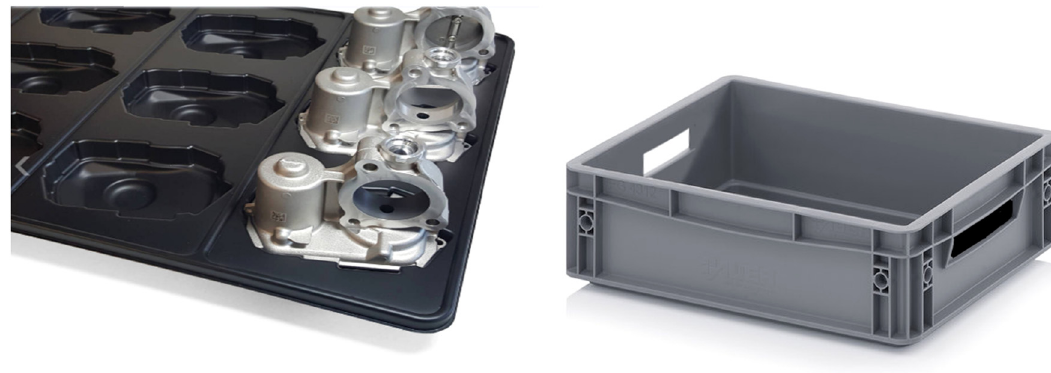
Figure 5: Plastic tray with workpieces and plastic EURO crate.